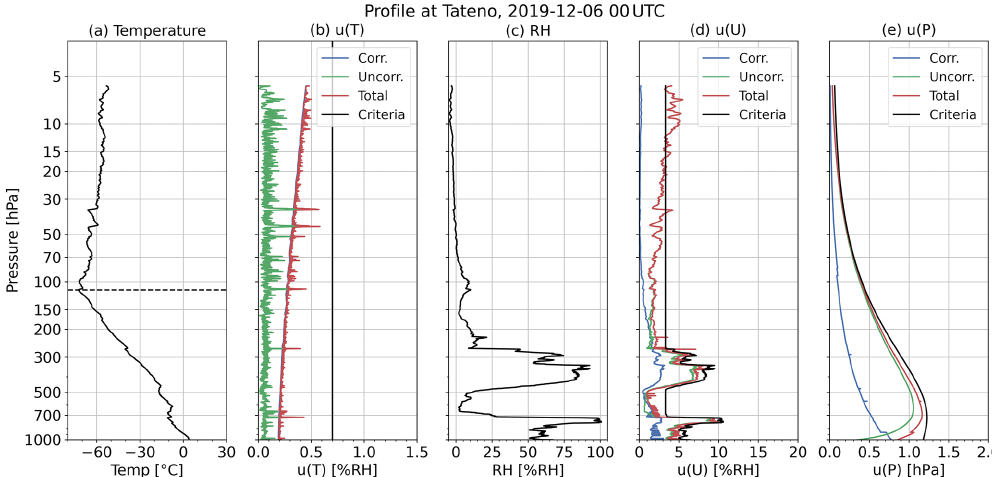
Figure 12. As per Fig. 4 but for the case at 00:00UTC on 6 December 2019.